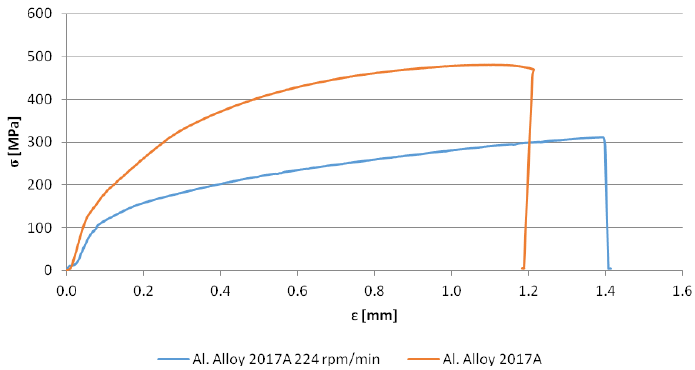
Figure 14. Static tensile test of the rod received after 224 rpm of the punch and a reference one.